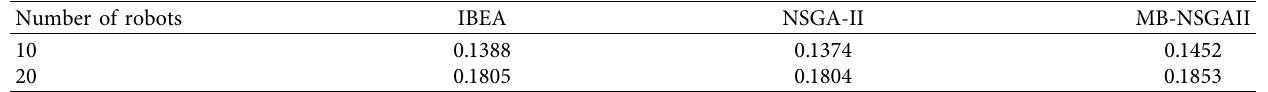
Table 7: Experimental results of HV when robots perform 500 tasks.